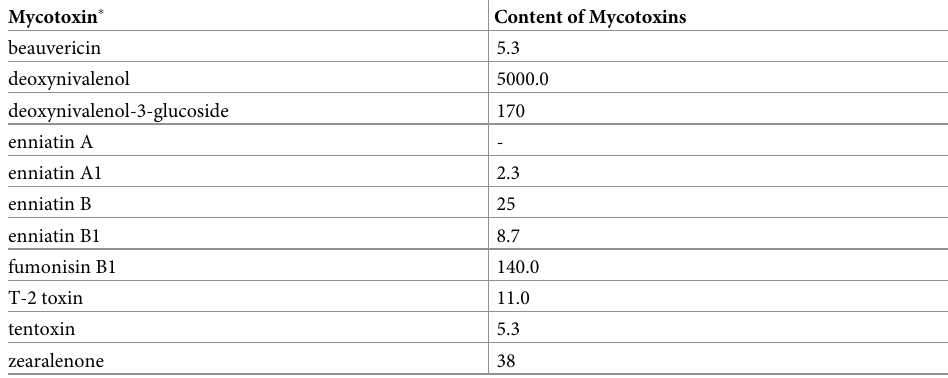
Table 3. The content of mycotoxins in the feed mixtures ( μ g/kg of dry